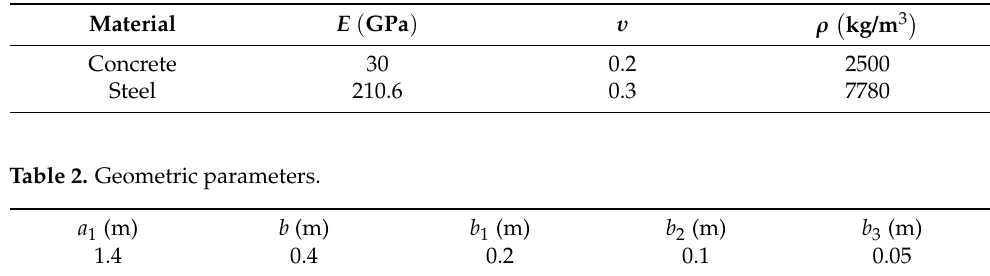
Figure 2. Dispersion curve: ( a ) Euler beam; ( b ) Timoshenko beam. Table 1. Material parameters.